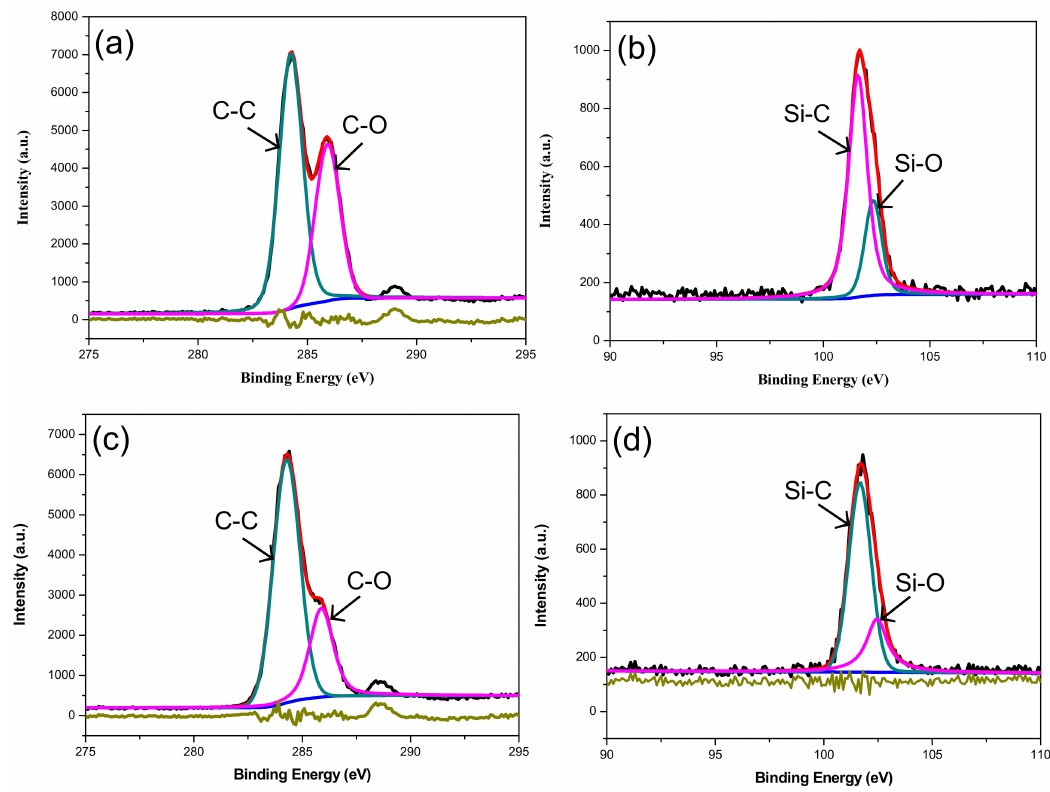
Figure 4. XPS spectra Si2p and C1s XPS spectra of deposition time 30 s and spraying distance 15 mm ( a , b ); deposition time 30 s and spraying distance 25 mm ( c , d